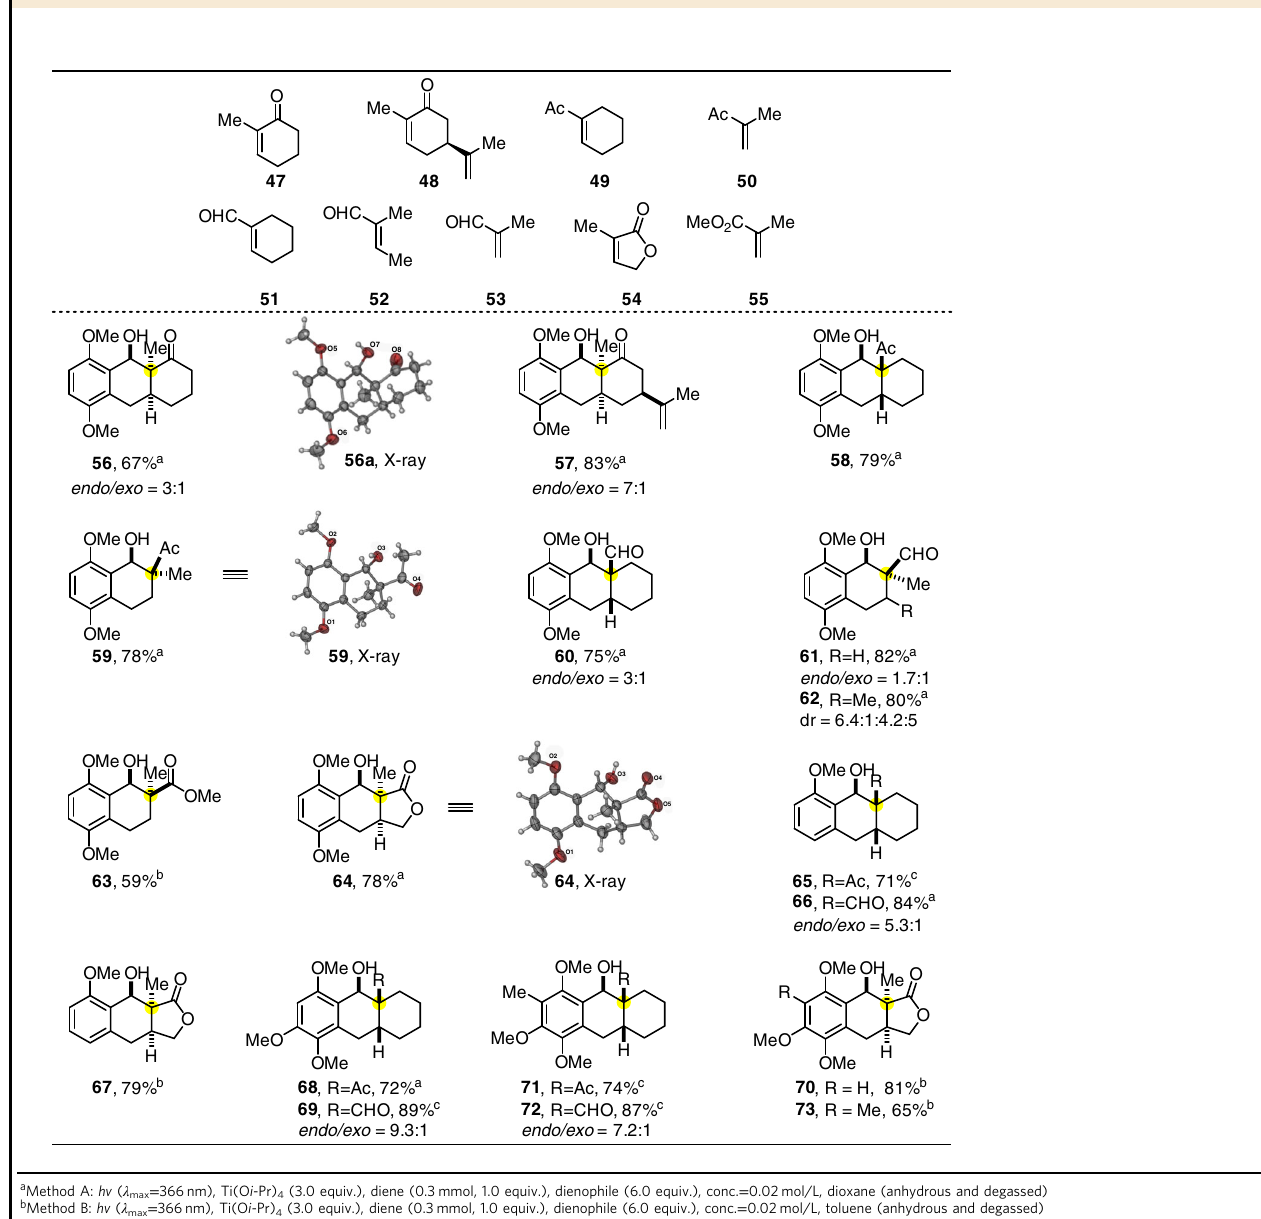
Table 3 Scope of the PEDA reaction involving 1,1-disubstituted ole fi ns as dienophiles